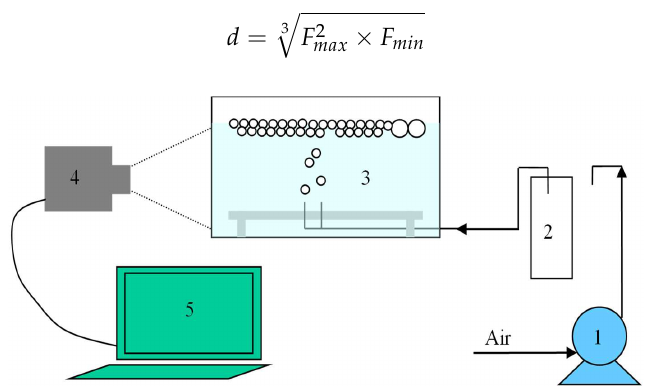
Figure 1. Experimental set up for critical coalescence concentration (CCC) measurements. ( 1 ) peristaltic pump; ( 2 ) equalizing tank; ( 3 ) cell, ( 4 ) digital camera; ( 5 ) computer [32].